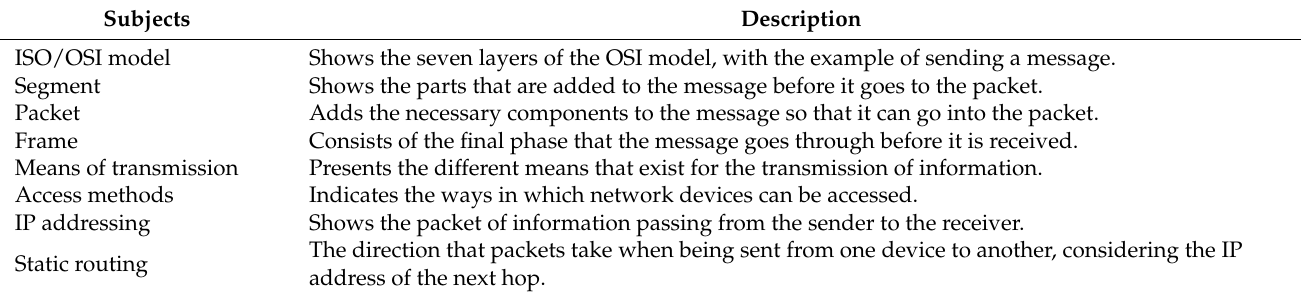
Table 1. Subjects used for the construction of